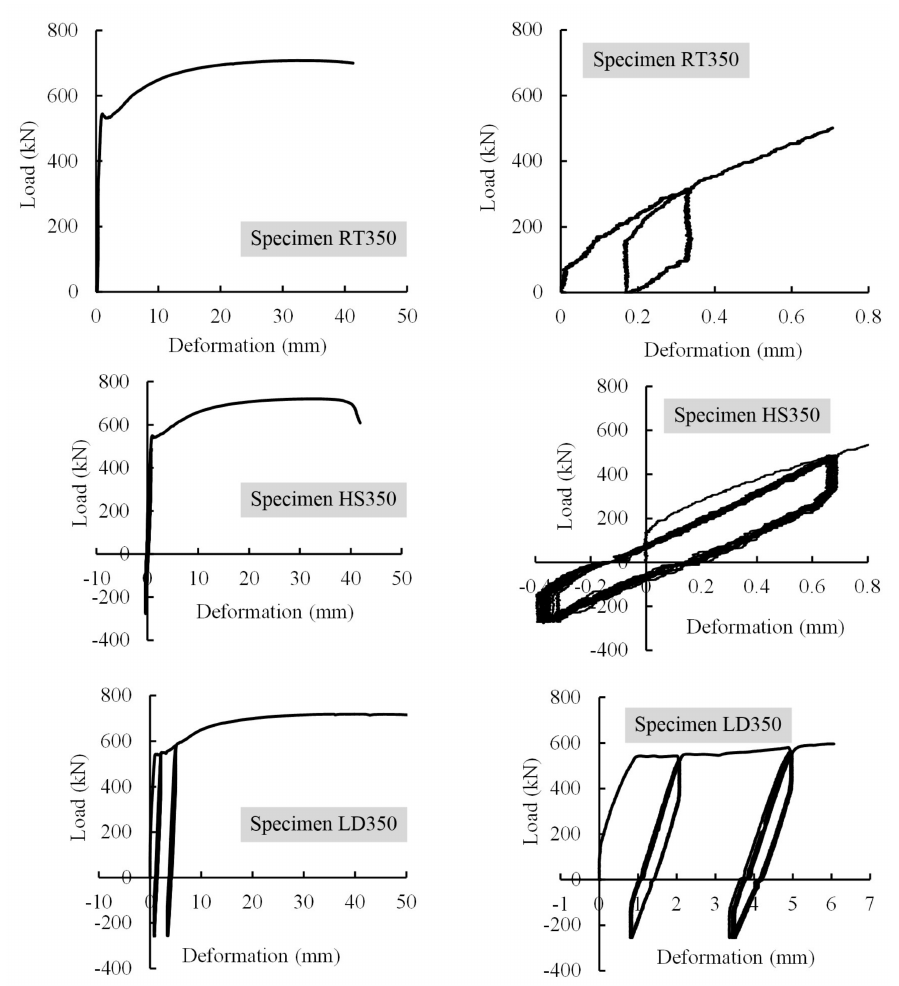
Figure 10. Load-splice deformation curves for Specimens RT350, HS350 and